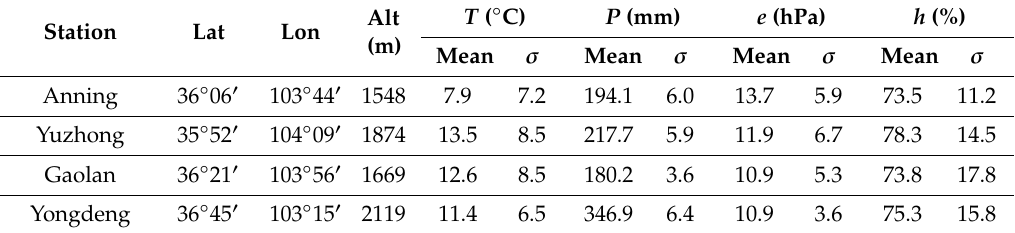
Table 1. Latitude (Lat), longitude (Lon), altitude (Alt), meteorological parameters ( T —air temperature, P —precipitation amount, e —water vapor pressure and h —relative humidity) and their standard deviations ( σ ) at four sampling stations in the Lanzhou city from 2011 to 2014.